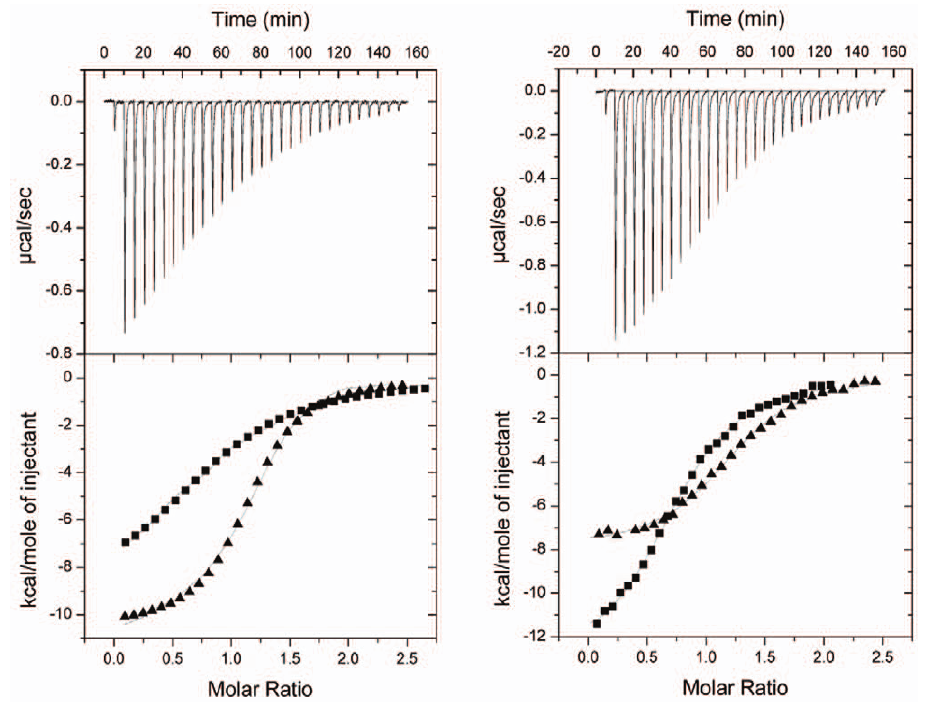
Figure 4. Characterisation of the interaction between NOXO1 and NOXA1. ( A ) Upper part shows the raw calorimetric data for the interaction between human NOXA1 SH3 and NOXO1 SH3 AB–E . Lower part shows the integrated heat changes, corrected for heat of dilution, and fitted to a single site binding model. ( & ) Human NOXA1 SH3 titrated into human NOXO1 SH3 AB–E ( m ) Mouse NOXA1 SH3 titrated into mouse NOXO1 SH3 AB–E . ( B ) Upper part shows raw calorimetric data for the interaction of peptideA and human NOXA1 SH3. Lower part shows the integrated heat changes, corrected for heat of dilution, and fitted to a single site binding model. ( & ) PeptideA titrated into human NOXA1 SH3 ( m ) PeptideA titrated